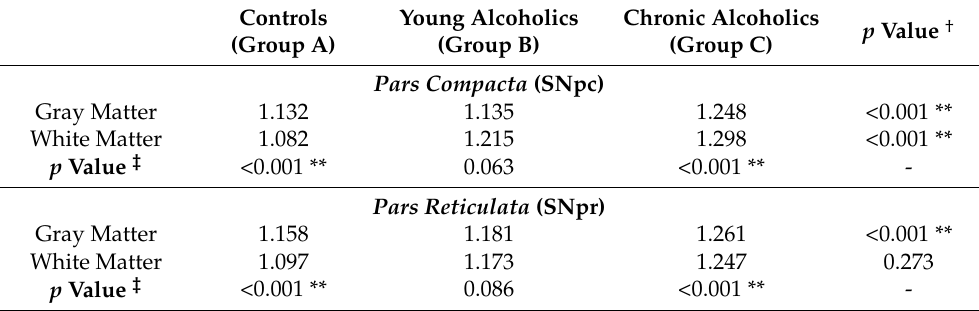
Table 8. Inter-group and intra-group comparisons of the differences in the grades of integrity based on expression of fibronectin in the BM of the microvessels in the SN region (shown by weighted average).